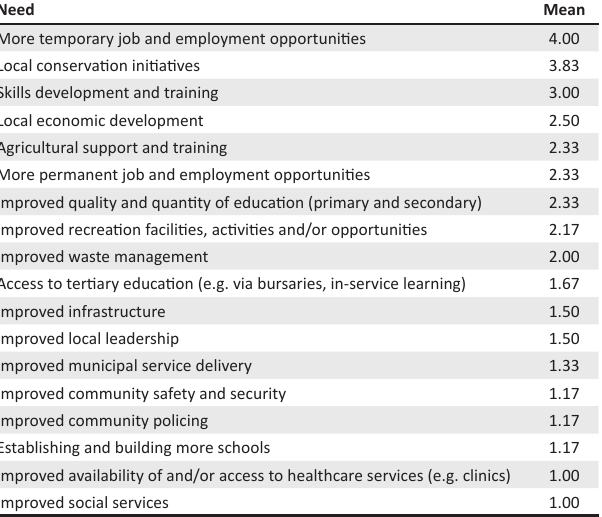
TABLE 4: Extent to which Mokala National Park and South African National Parks could potentially address development needs in communities.